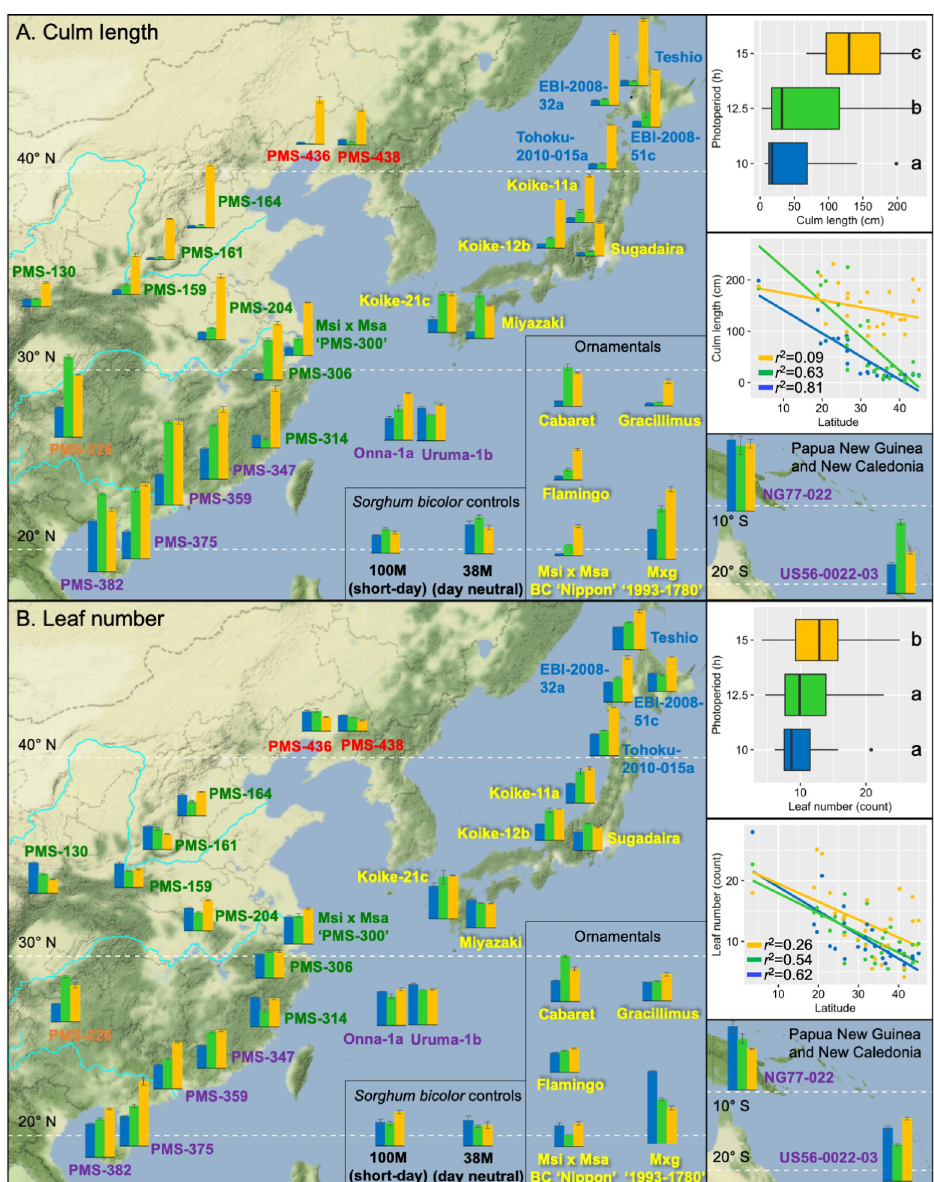
Fig 5. Effects of day length on culm length (A), and leaf number (B) for 33 Miscanthus and two Sorghum bicolor genotypes grown in controlled environment chambers at constant 23 ˚C. The Miscanthus genotypes included 28 M . sinensis , 2 M . floridulus , 2 diploid M . × giganteus , and 1 triploid M . × giganteus . The genotypes were evaluated for response to three day length treatments: 15 h (orange data), 12.5 h (green data) and 10 h (blue data), respectively. Collection sites of the genotypes obtained from the wild are shown by their placement on the geographic map. Miscanthus genotype names are printed in colors representing six M . sinensis genetic groups identified by Clark et al . [23, 24], which included Korea/North China (red), Yangtze-Qinling (green), Northern Japan (blue), Southern Japan (yellow), Sichuan Basin (orange), and Southeastern China plus tropical (purple); for interspecific hybrids between M . sacchariflorus and M . sinensis , the dominant M . sinensis genetic group is shown. The inset boxplots depict variation among and within the three day-length treatments; treatments labeled with the same letter were not significantly different based on Tukey’s HSD test at α = 0.05. The inset regression plots show linear relationships between traits and absolute values of latitude at collection sites for the 28 Miscanthus genotypes with geographical information. Note that under 15 h days culm length was greatest and only weakly associated with latitude of origin, whereas culm length shortest under 10 h days but strongly associated with latitude of origin. Also note that accessions from central and northern Japan had fewer leaves under 10 and 12.5 h than at 15 h; in contrast, accessions from similar latitudes in China when grown under short days had similar or greater numbers of leaves as under long days, yet the